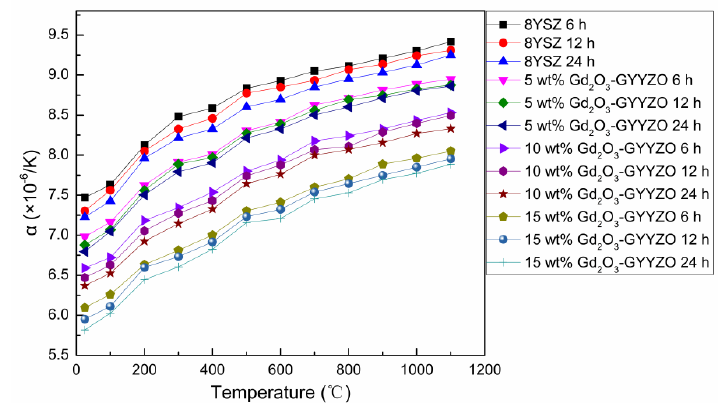
Figure 5. Thermal expansion coefficient of the sintered bulks.